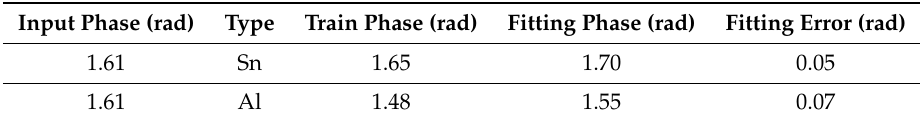
Table 3. Analysis about the wrong